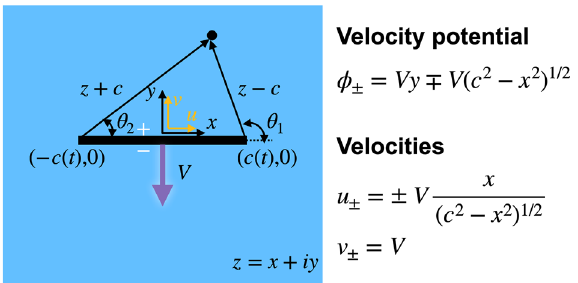
Figure 2. Schematic of the motion of a thin plate. A thin plate with a width of 2 c moves in a fluid at a speed of V : V < 0 for this drawing. The complex domain is defined as z = x + iy . The resulting velocity potential, φ , and velocities, u & v , are given on the right. The subscript ( + or −) represents the top or bottom side of the plate,